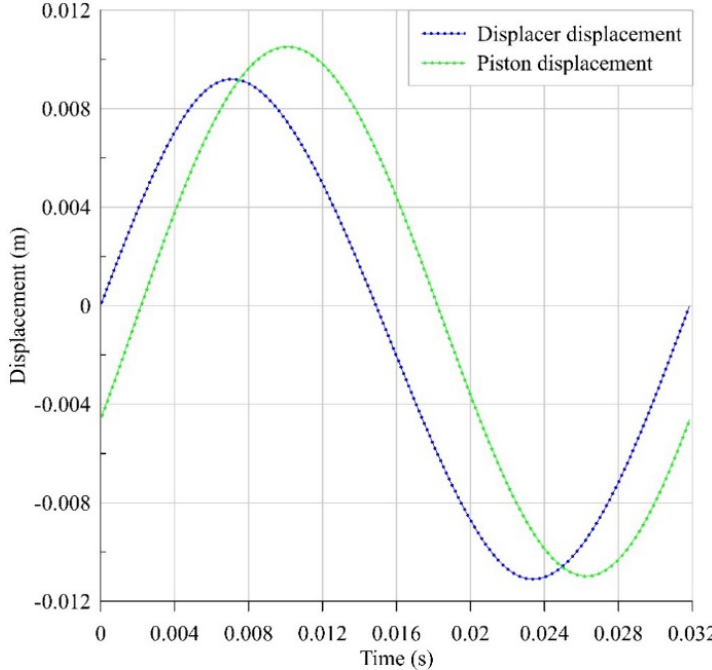
Figure 3. Displacer and piston displacement.